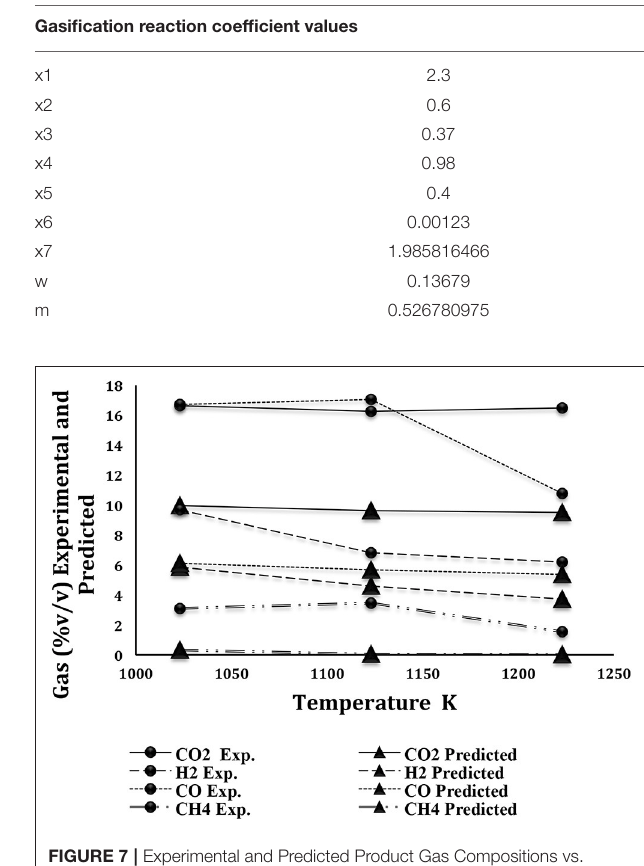
TABLE 3B | Model results: reaction coefficient values.